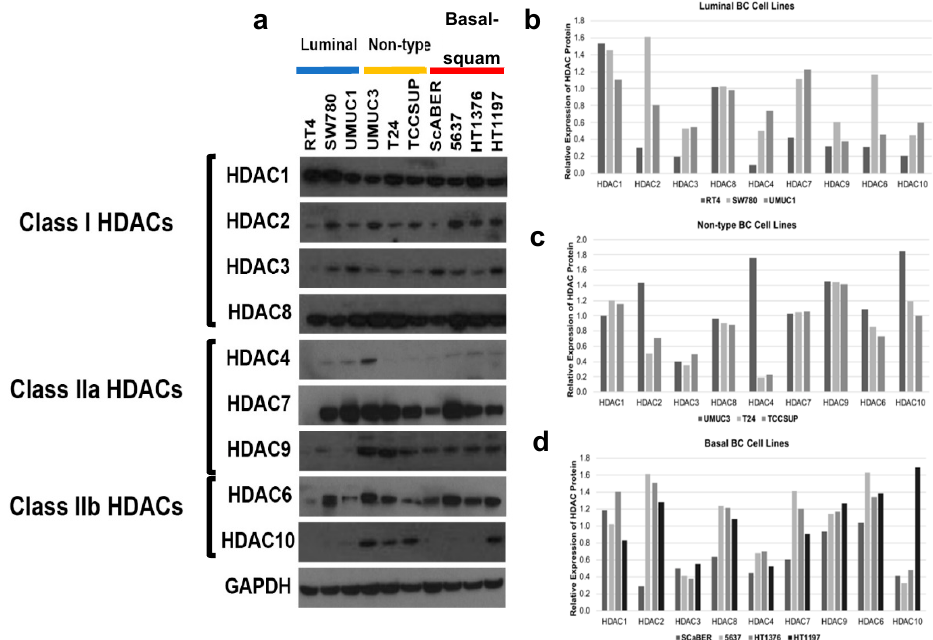
Figure 3. HDAC9 is overexpressed in basal-squamous and non-type human BC cell lines. ( a ) Western blotting of histone deacetylase (HDAC) expression in a panel of 10 human BC cell lines, classified as luminal (RT4, SW780, UMUC1), non-type (UMUC3, T24, TCCSUP) and basal–squamous (SCaBER, 5637, HT1376, HT1197). Densitometry is depicted in ( b – d ). Expression of HDAC1, 2, 3, 6, 7, and 8 appeared to be independent of molecular subtype assignment in human BC cell lines. HDAC4 protein was detected at low levels in SW780, UMUC1, UMUC3 and in 5637, HT1376, and HT1197. On the other hand, HDAC9 was robustly expressed in non-type and basal cell lines, with low levels detected in luminal lines. Interestingly, HDAC10 was expressed primarily in human BC cells with a non-type molecular